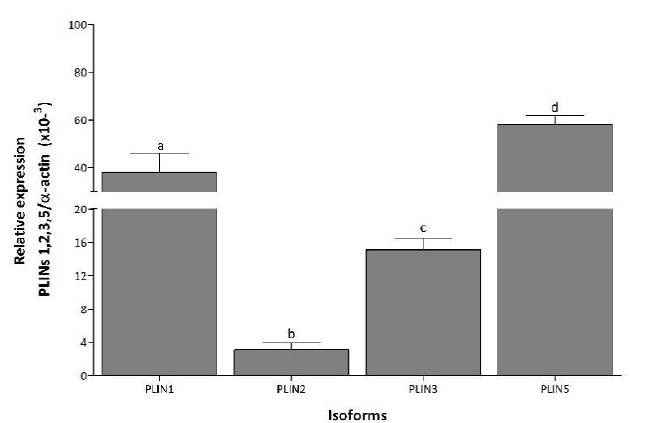
Figure 1. Differential expression of PLIN isoforms in left ventricle. Mean (± S.E.M.) mRNA expression levels of PLIN1, 2, 3, and 5 in left ventricle of non-pregnant rats. Values with the same letter are not significantly different ( p < 0.05).